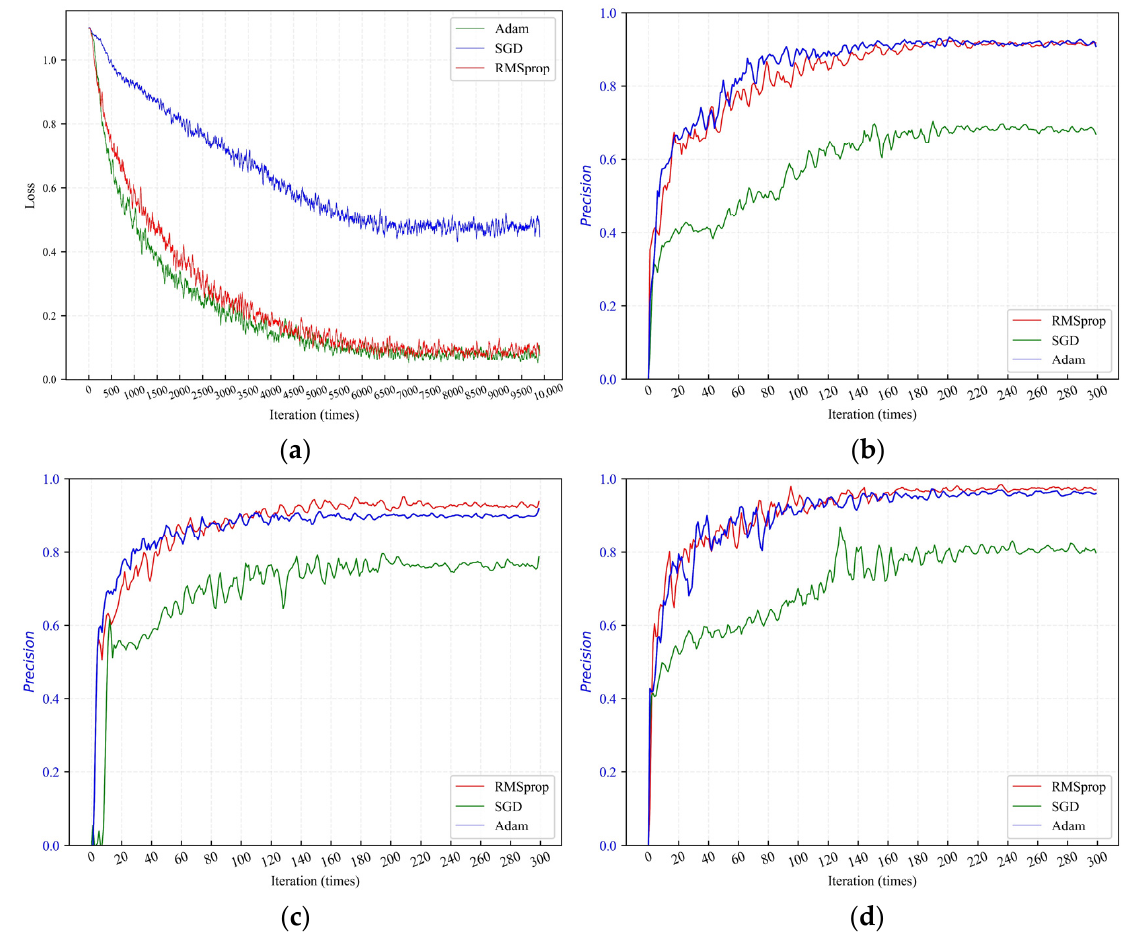
Figure 23. ( a ) Training loss of ShuffleNetV2 under three optimizers; ( b ) results of metamorphic rock under three optimizers; ( c ) results of sedimentary rock; and ( d ) results of volcanic rock.